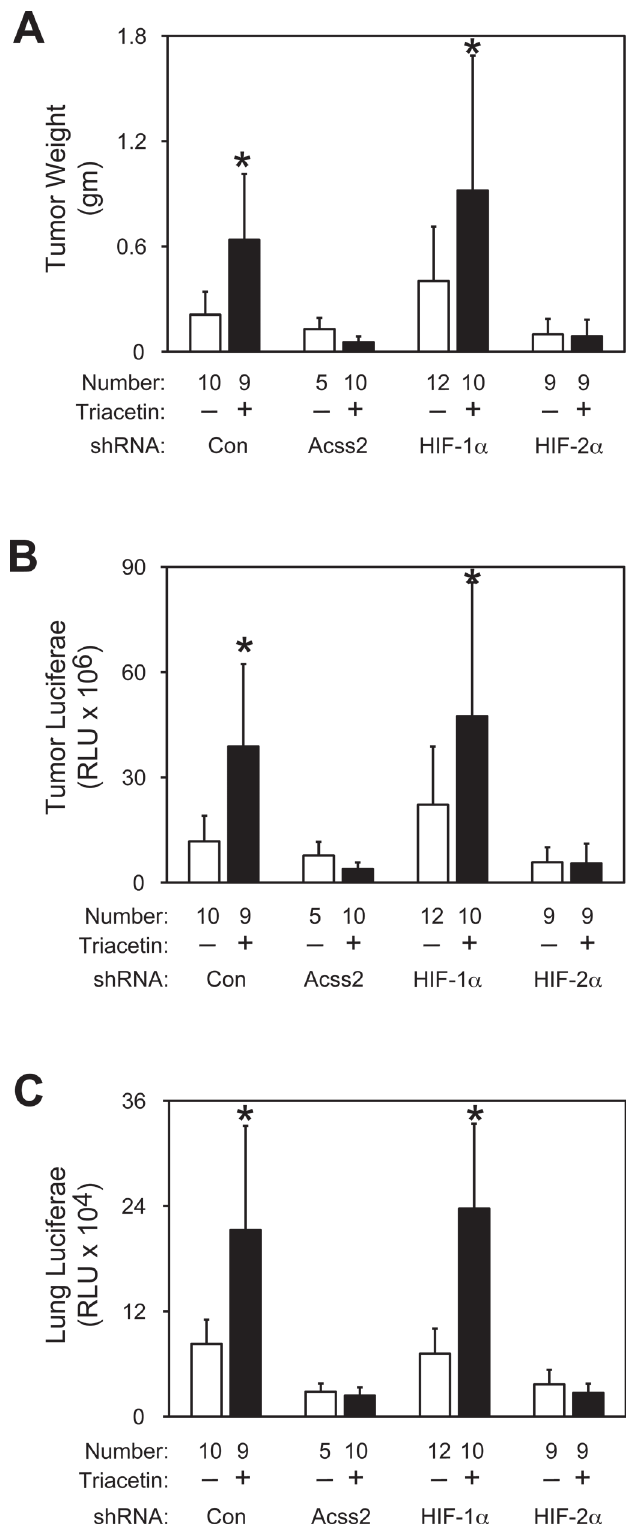
Fig 7. ACSS2 and HIF-2 α regulate in vivo tumor cell properties. (A) Weights of flank tumors derived from HT1080 cells expressing control (white bars), ACSS2 (black bars), HIF-1 α (light gray bars), or HIF-2 α